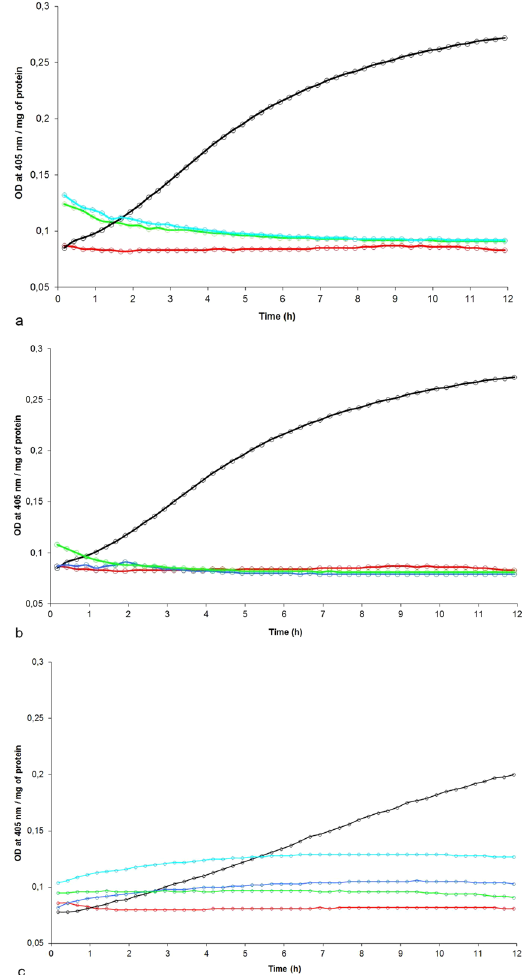
Figure 4. Specificity of the caspase-3 activity induced by PA1b. The weevils were intoxicated for 24 h with PA1b, 400 µ g per g of food. After intoxication, the midguts were dissected and the caspase -3 activities were measured using the artificial substrate DEVD-pNA. ( a ) Sensitive weevil strain WAA42 intoxicated with PA1b (black) and control (without toxin, red); resistant weevil strain ISOR3 intoxicated with PA1b (blue) and control (green). ( b ) Sensitive weevil strain WAA42 intoxicated with PA1b (black); with reduced and alkylated PA1b (green); with the inactive mutant F10A (blue); and control (red). ( c ) Sensitive weevil strain WAA42 intoxicated with PA1b (black); control (red); with bafilomycin at 0.25 mM (dark blue) and at 0.8 mM (light blue); resistant weevil strain ISOR3 intoxicated with bafilomycin at 0.8 mM